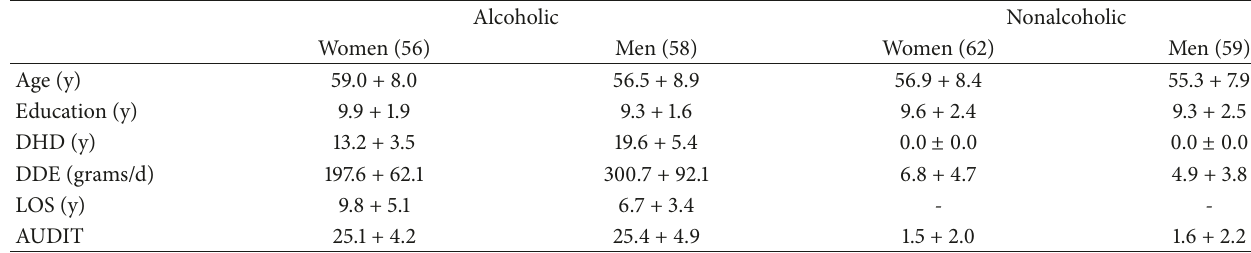
Table 1: Demographic